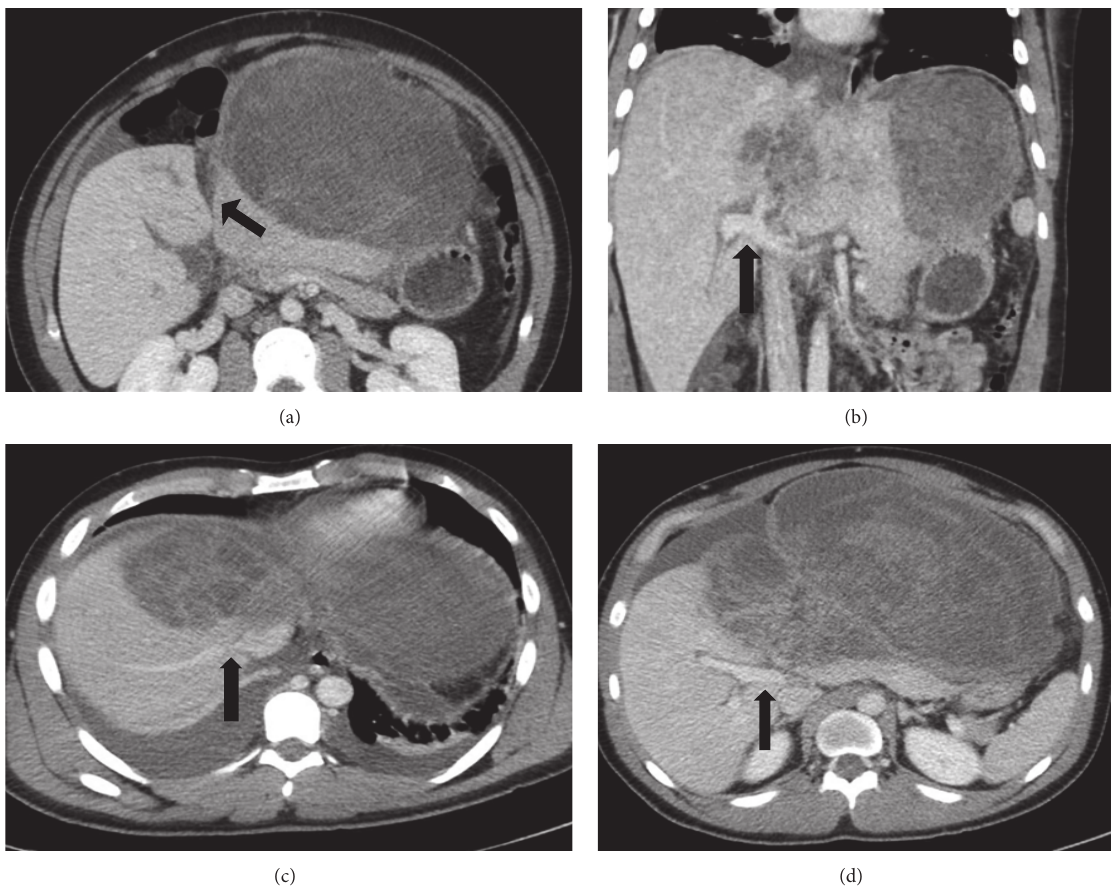
Figure 2: CT abdomen and pelvis with intravenous contrast showing large, heterogeneous left hepatic mass. Characterization of mass with regard to hepatic landmarks. (a) Arrow points to umbilical fissure. (b) Arrow identifies portal vein bifurcation. (c) Arrow points to juncture of right hepatic vein with inferior vena cava. (d) Arrow indicates right portal